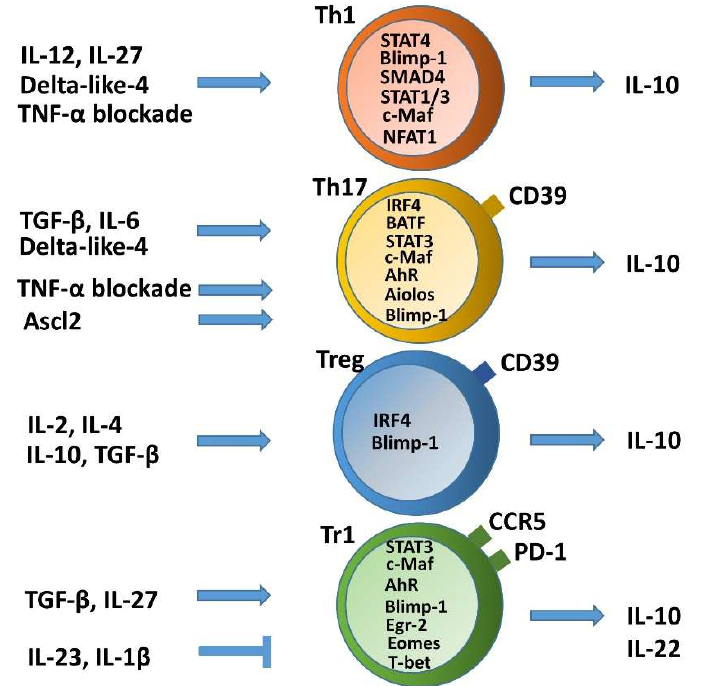
Figure 2. IL-10 expression in T helper lineages represents plasticity of several T helper cell differentiation pathways. Different T cell subsets secrete IL-10 when stimulated by a variety of cytokines. In particular, IL-27 and TGF-β broadly induce IL-10 production from various T cell subsets. 3. Heterogeneity and Plasticity of T Helper Cells in Inflammatory Bowel Disease (IBD)